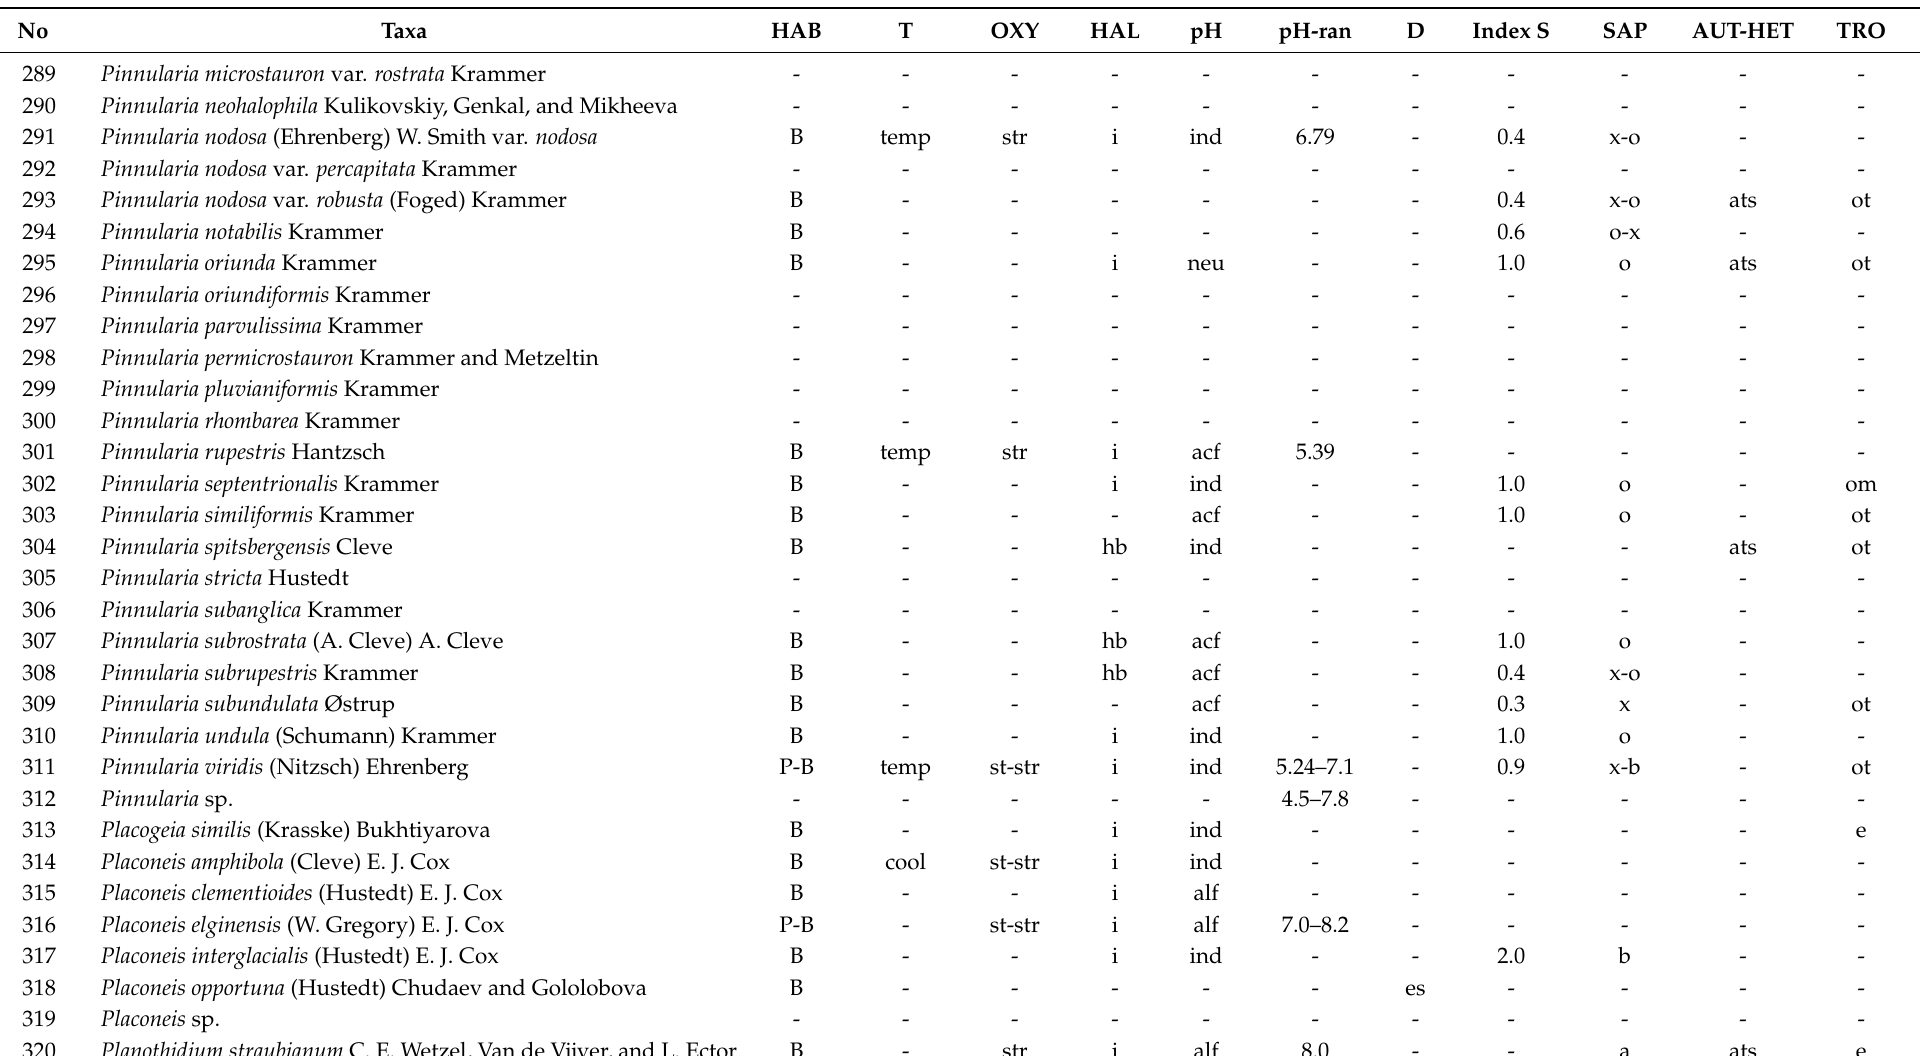
No 289 Pinnularia microstauron var. rostrata Krammer 290 Pinnularia neohalophila Kulikovskiy, Genkal, and Mikheeva 291 Pinnularia nodosa (Ehrenberg) W. Smith var. nodosa 292 Pinnularia nodosa var. percapitata Krammer 293 Pinnularia nodosa var. robusta (Foged) Krammer 294 Pinnularia notabilis Krammer 295 Pinnularia oriunda Krammer Pinnularia oriundiformis Krammer 297 Pinnularia parvulissima Krammer Pinnularia permicrostauron Krammer and Metzeltin Pinnularia pluvianiformis Krammer Pinnularia rhombarea Krammer Pinnularia rupestris Hantzsch Pinnularia septentrionalis Krammer Pinnularia similiformis Krammer 304 Pinnularia spitsbergensis Cleve 305 Pinnularia stricta Hustedt 306 Pinnularia subanglica Krammer 307 Pinnularia subrostrata (A. Cleve) A. Cleve 308 Pinnularia subrupestris Krammer 309 Pinnularia subundulata Østrup 310 Pinnularia undula (Schumann) Krammer 311 Pinnularia viridis (Nitzsch) Ehrenberg 312 Pinnularia sp. 313 Placogeia similis (Krasske) Bukhtiyarova 314 Placoneis amphibola (Cleve) E. J. Cox 315 Placoneis clementioides (Hustedt) E. J. Cox 316 Placoneis elginensis (W. Gregory) E. J. Cox Placoneis interglacialis (Hustedt) E. J. Cox Placoneis opportuna (Hustedt) Chudaev and